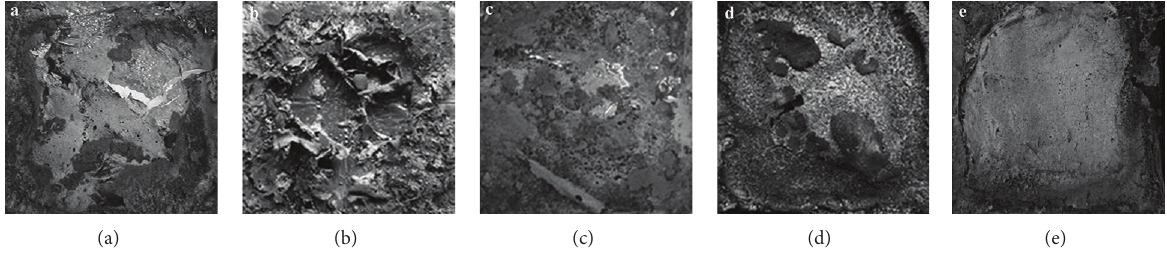
Figure 7: Digital images of char residue after cone calorimeter test: (a) neat PU, (b) DPTP (2 phr), (d) DPTP (5phr), (e) DPTP (8 phr), and (f) DPTP